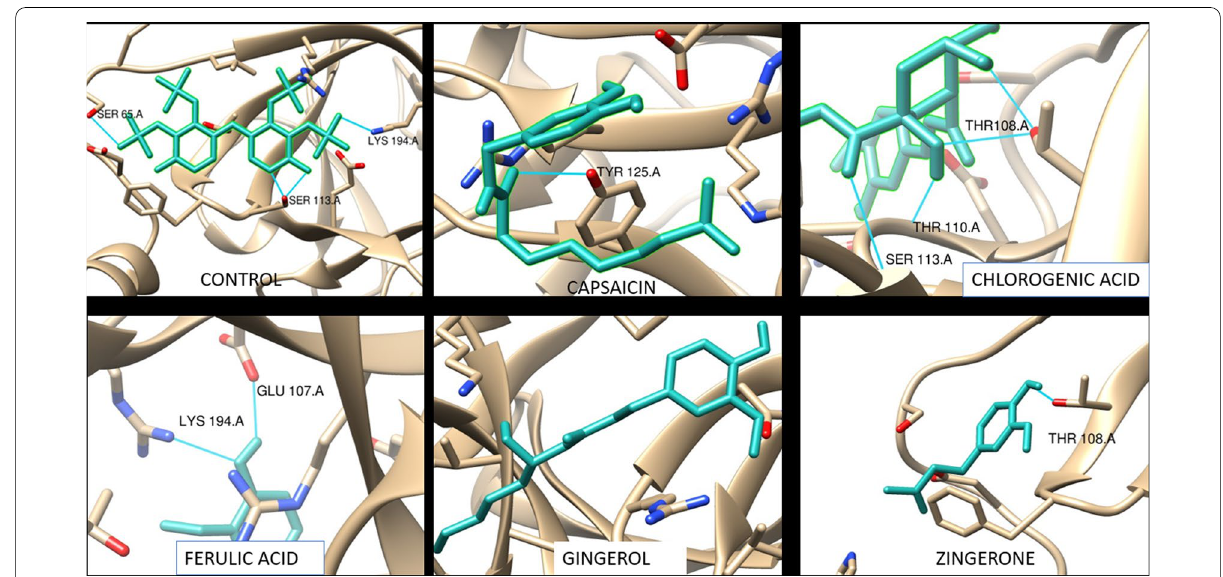
Fig. 1 Docked pictures of curcumin analogues and pentosan polysulfate (control) against FGF receptor. (Ligand represents the blue sticks, hydrogen bond interaction is represented in blue line, and receptor is represented in solid white ribbon form)